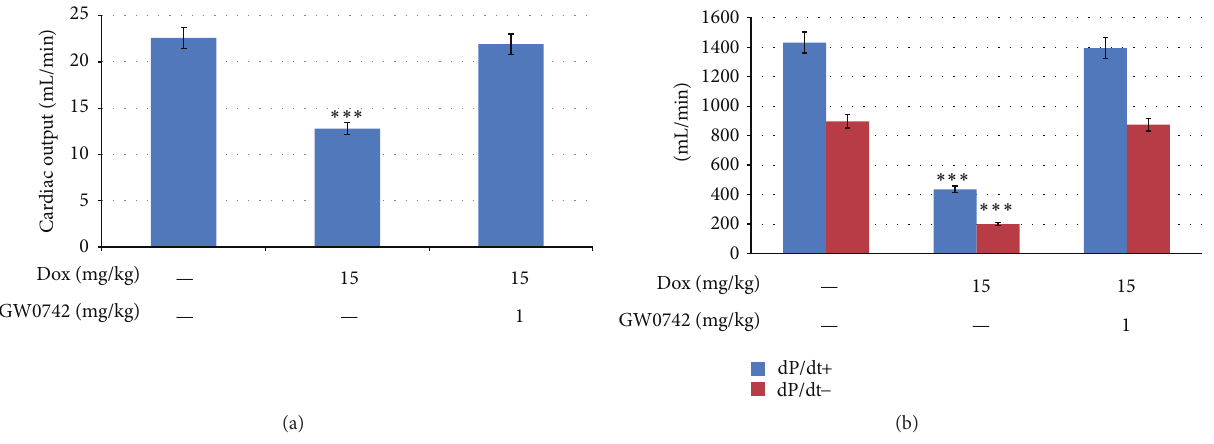
Figure2:EffectofGW0742oncardiacoutputandhemodynamicdP/dtinDOX-treatedrats.Changesincardiacoutput(a)andhemodynamic dP/dt (b) in DOX-treated rats by a 3-day treatment of GW0742 (1mg/kg, S.C). Data represent mean ± SE of six experiments. ∗∗ 𝑃 < 0.01 as compared with control